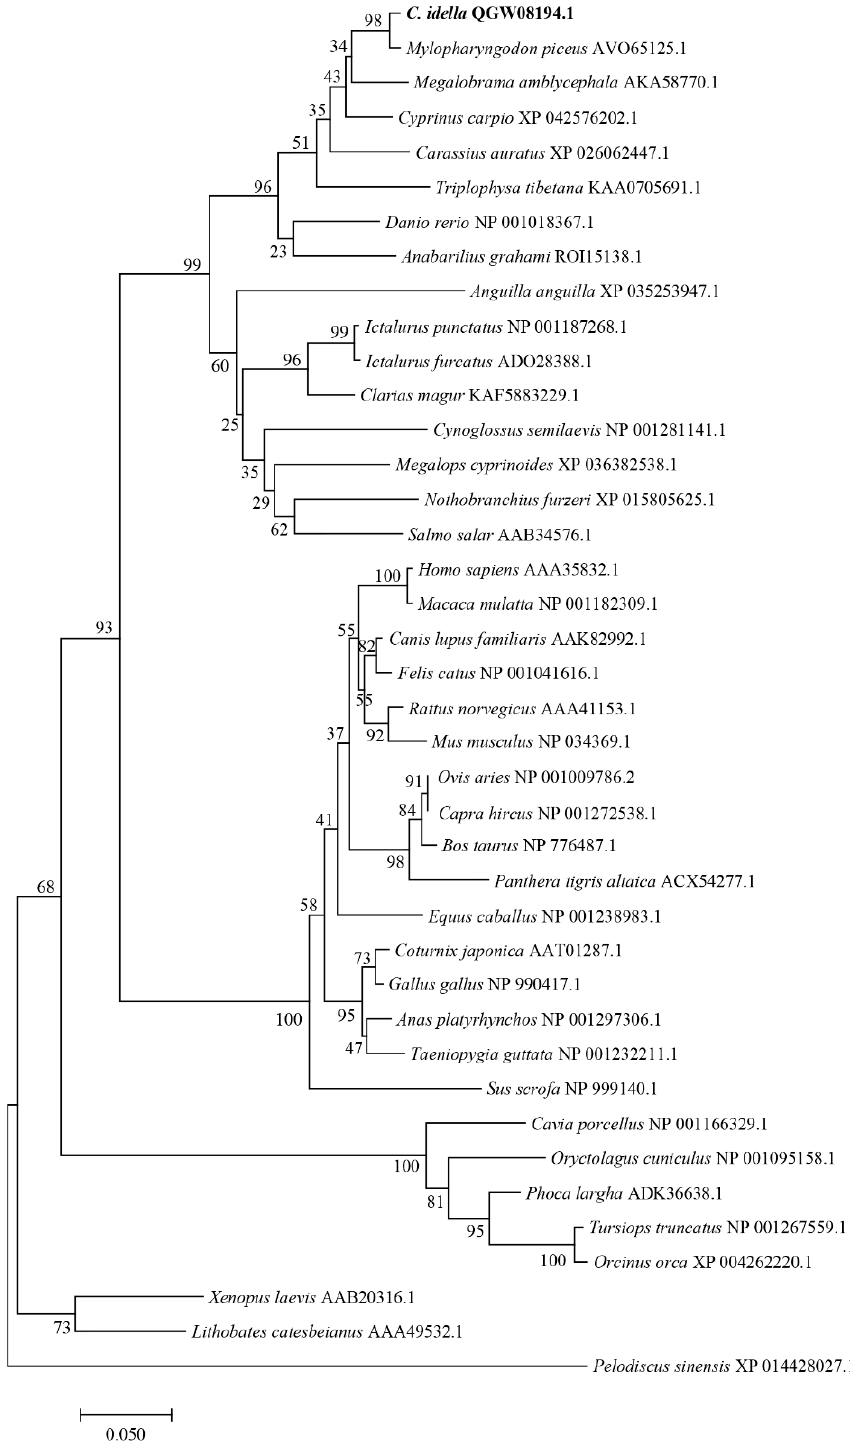
Figure 4. Phylogenetic tree of ferritins.